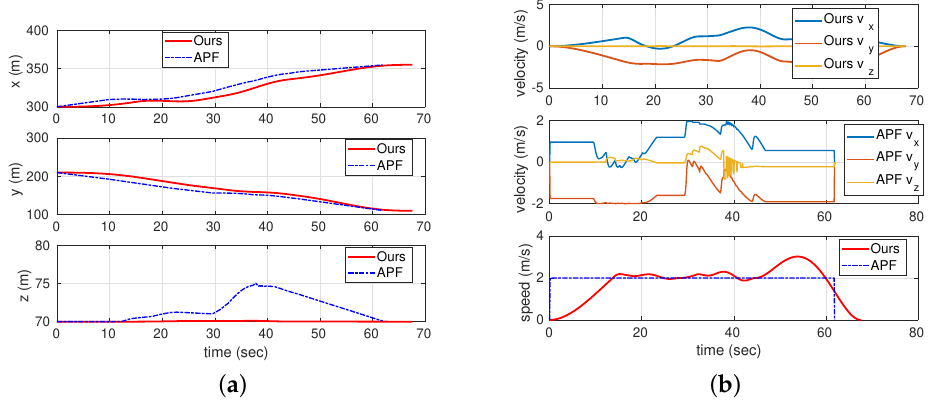
Figure 12. Translation of the static obstacles only case ( a ) Position ( b ) Linear velocity and speed.